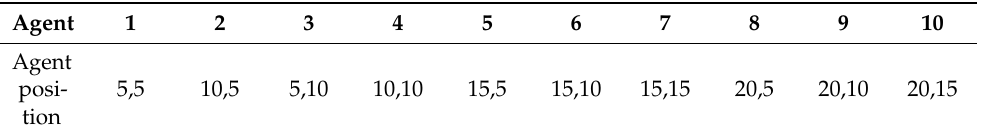
Table 1. Agent state position.